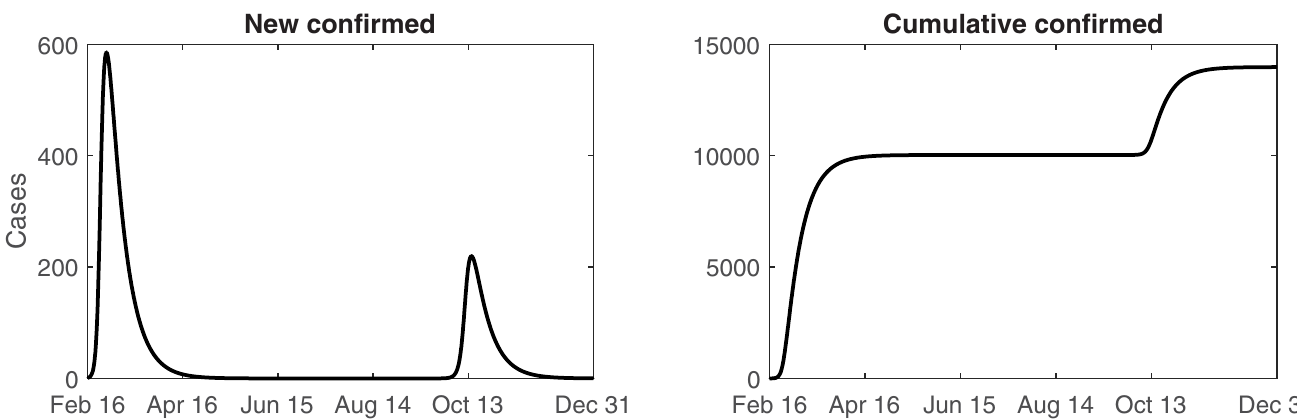
Fig 4. Expected number of cases from the model until the end of 2020. Daily (left) and cumulative (right) number of confirmed cases.